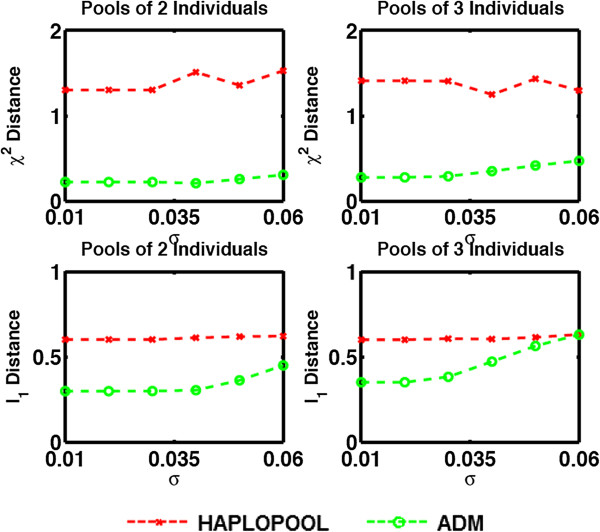
Measures of performance of HAPLOPOOL and ADM applied to the HapMap dataset with noisy observations.